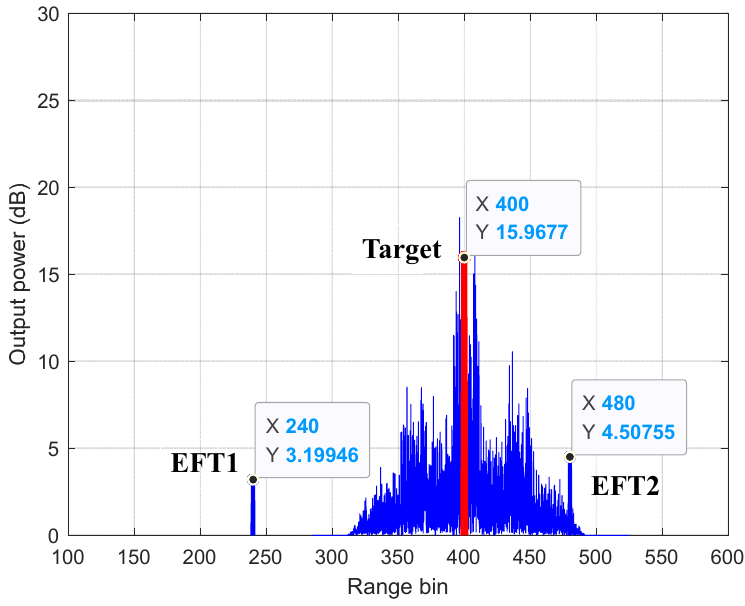
Figure 7. Analysis results of existing jamming range bin under non-adaptive beamforming.